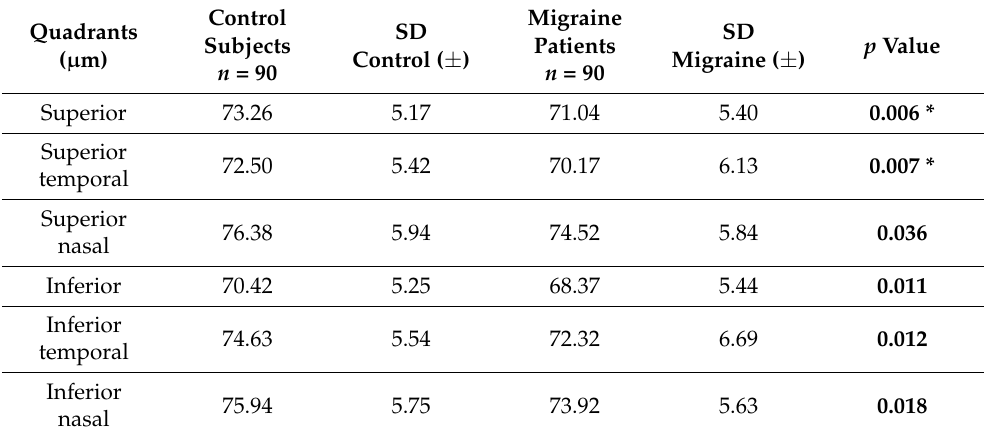
Table 9. GCL+ thickness ( µ m) in each of the 90 ◦ quadrants around the macula. Quadrants ( µ m)